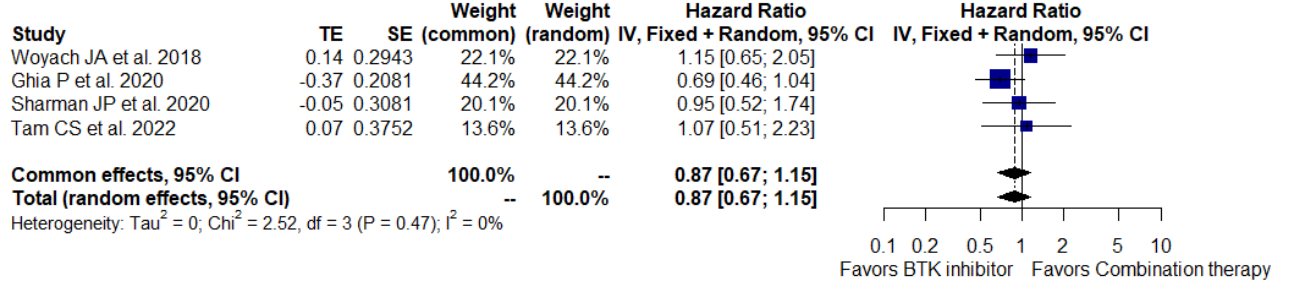
Figure 3. Forest plot for overall survival [25,30,42,45].